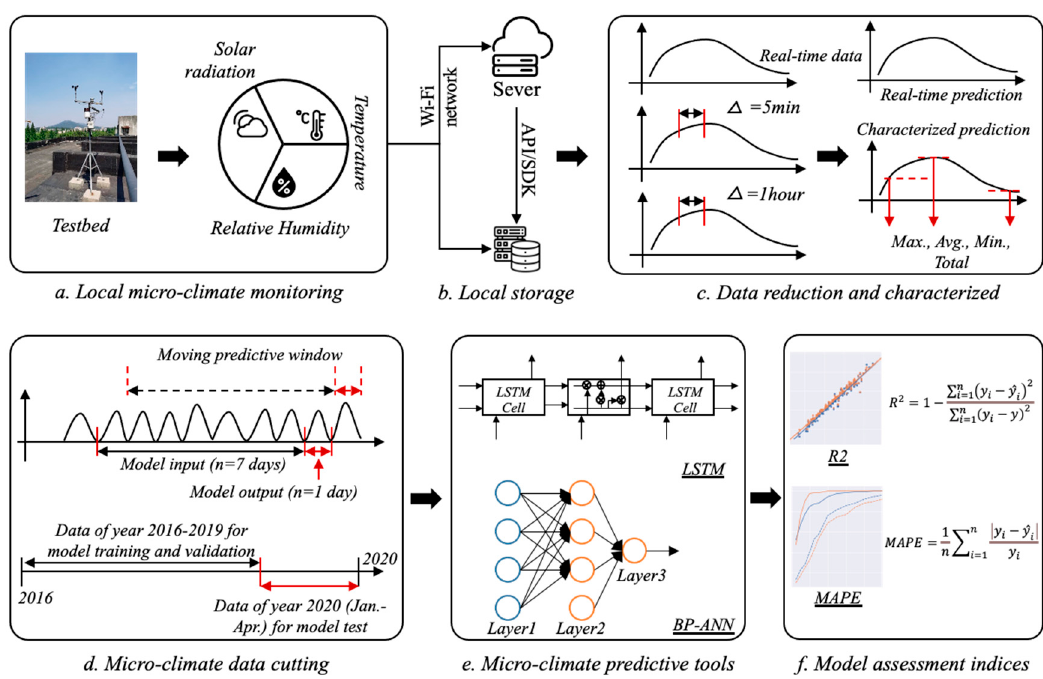
Figure 1. The overview of the methodology for microclimate prediction in this study.